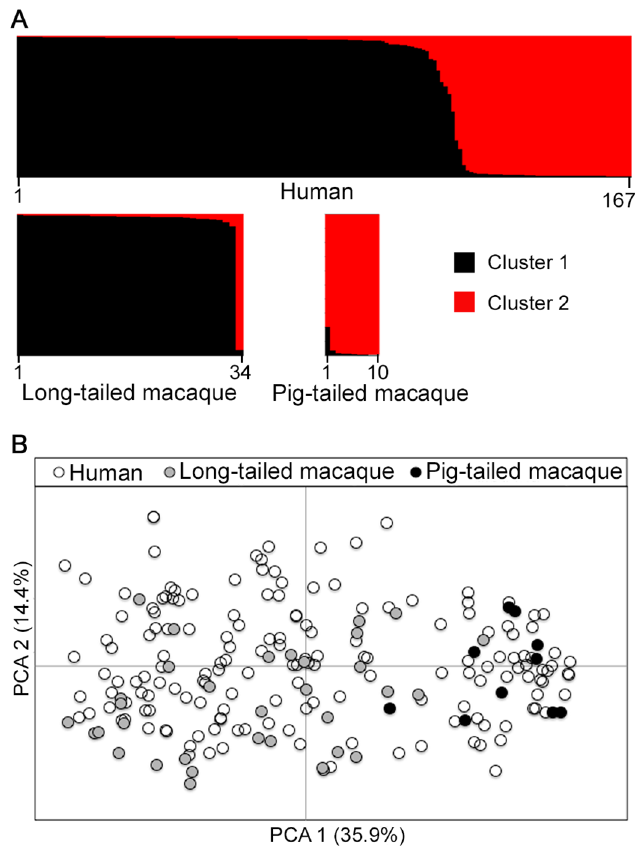
Fig 3. Population genetic structure of P . knowlesi from infections in three host species in Kapit. Both STRUCTURE and principal component analyses were conducted based on the complete 10-locus genotype dataset (167 from humans, 34 from long-tailed macaques, 10 from pig-tailed macaques). (A) Bayesian model-based STRUCTURE analysis indicates two subpopulation clusters throughout the whole dataset ( K = 2, Δ K = 936.75), with almost complete partitioning between the two macaque host species. Cluster 1 is shown in black while Cluster 2 is in red. (B) Principal component analysis (PCA) of the genetic divergence among all infections. The percentage of variation captured by each of the first two principal components is shown in brackets. Infections from the different macaque host species are almost completely separated by the first principal component, while human infections are distributed throughout the full range on both